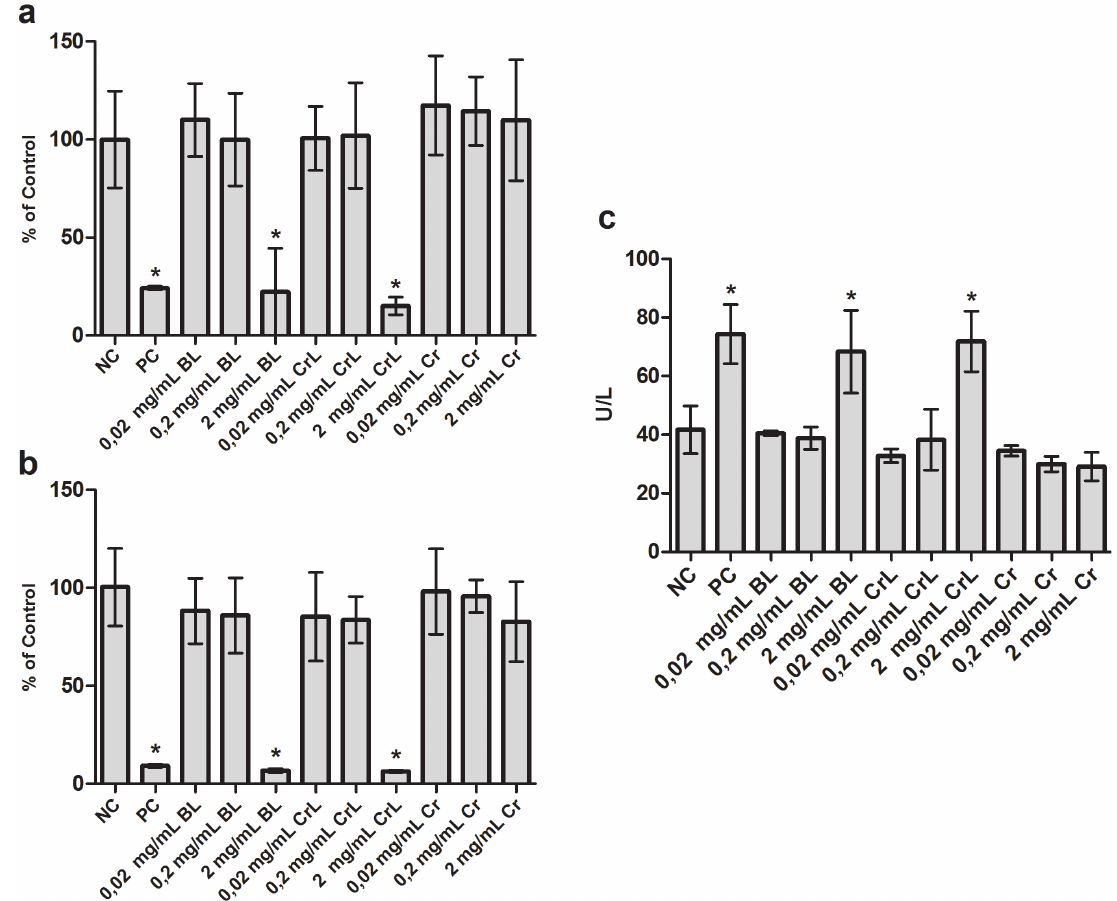
Figure 2 - MTT reduction in Vero cells after 24 ( a ) or 72 h ( b ) of treatment with CrL. ( c ) LDH activity in Vero cells. Negative Control (NC), Blank Liposomes (BL), Creatine Liposomes (CrL), Creatine (Cr). Results are expressed as percentage of the control (100% cell viability). Bars represent mean ± SD. *p < 0.05 compared to